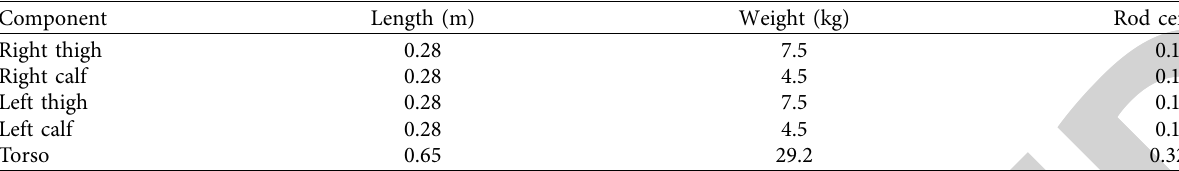
Table 3: Compass-like biped robot lower limb member parameter